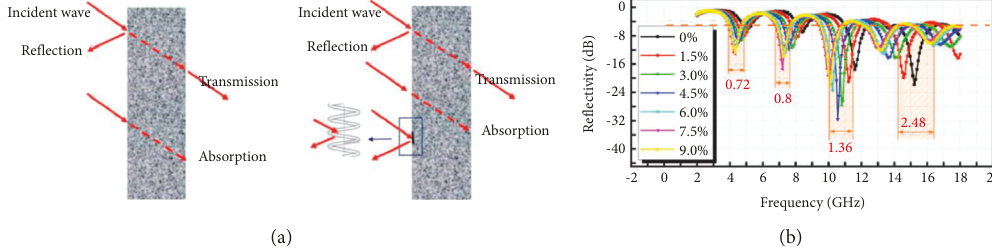
Figure 10: (a) Schematic diagram of reflection loss mechanism between plain concrete and smart concrete filled with spiral carbon fiber [66] (b) reflectivity of concrete with different carbon fiber content [66].